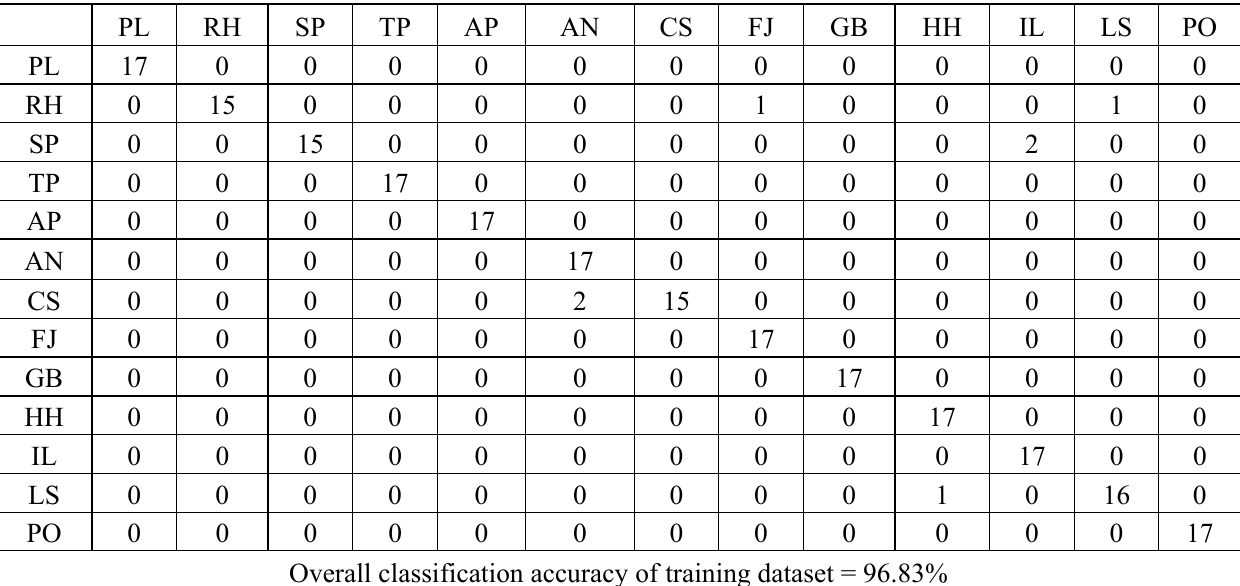
Table 2. The average confusion matrix (of 40 runs) for the training and testing dataset, the bands selected by genetic algorithms during training are used for evaluation by the testing